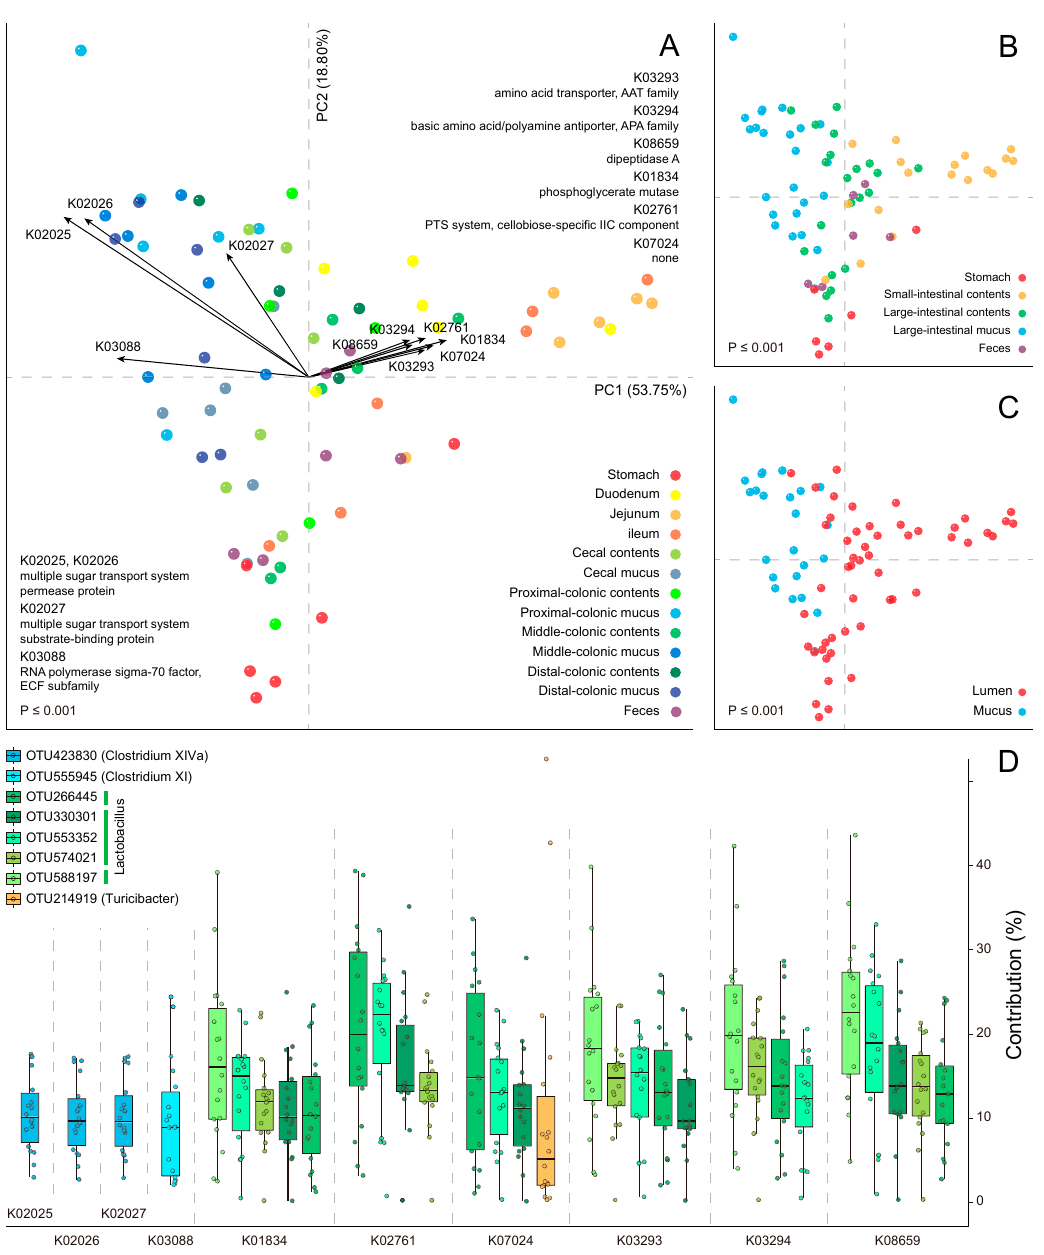
Figure 1. The spatial heterogeneity in the rat microbial community functions: a principal component analysis (PCA) based on the Kyoto Encyclopaedia of Genes and Genomes (KEGG) orthologue (KO) profiles of gut microbiome across the rat gastrointestinal tract (GIT), where potential relationships between metabolic variability and sample metadata are highlighted in panels A to C by different colorations. The permutational multivariate analysis of variance (PERMANOVA) results reveal the grouping of samples from the same ( A ) sampling site (adonis: R 2 = 0.60), ( B ) anatomic region ( R 2 = 0.47) and ( C ) niche location ( R 2 = 0.24). The p -value of the Monte Carlo permutation test is shown on the lower left. The percentages of variation explained by first principal component (PC1) and second principal component (PC2) are listed along the axes representing them. The top 10 KOs driving the heterogeneity are indicated in panel A . For different anatomic regions, the major contributing operational taxonomic units (OTUs) and their contributions to these KOs are shown in panel ( D) .